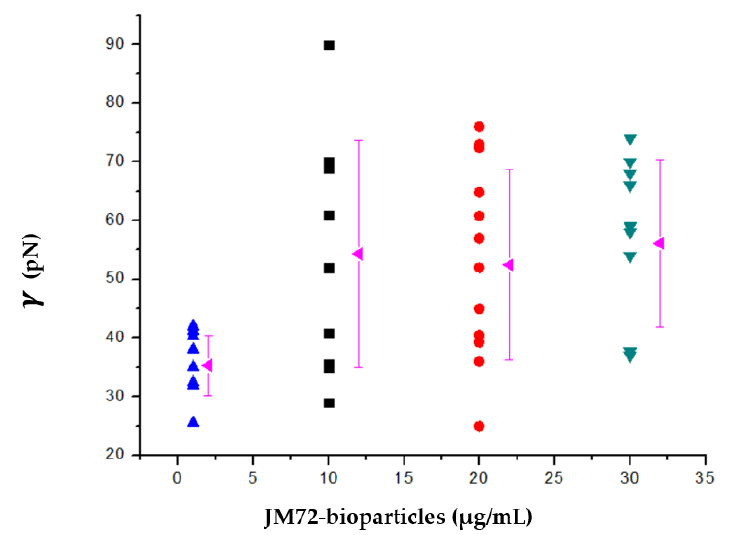
Figure 4. Pore edge tension of POPC giant unilamellar vesicles as a function of JM72-bioparticles concentration. Each point corresponds to a result for a single vesicle and rose triangles correspond to average and variation bars to standard deviation.